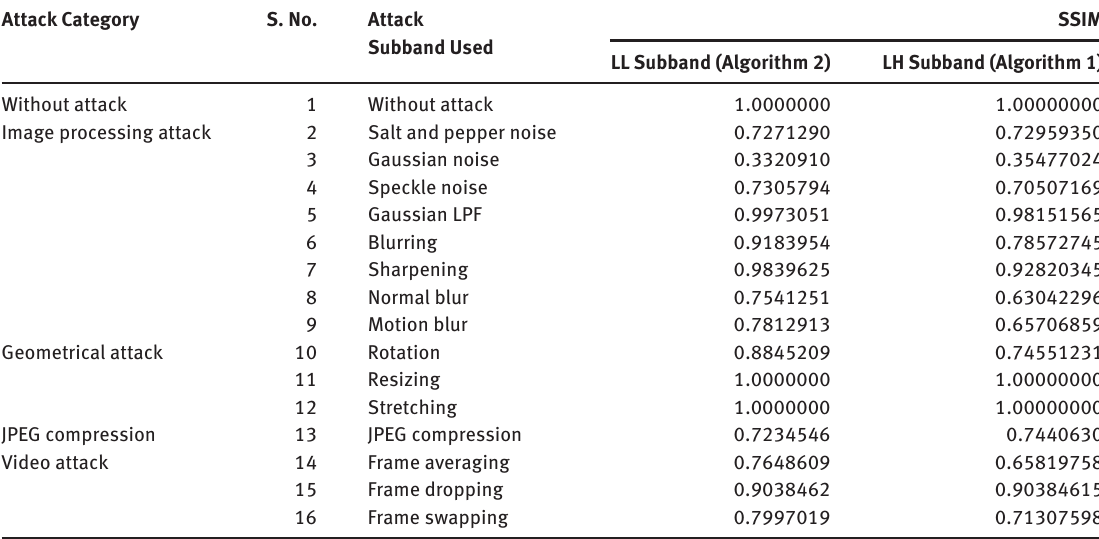
Table 12: Comparative analysis of SSIM between Watermarking Using LL and LH Subbands. Attack